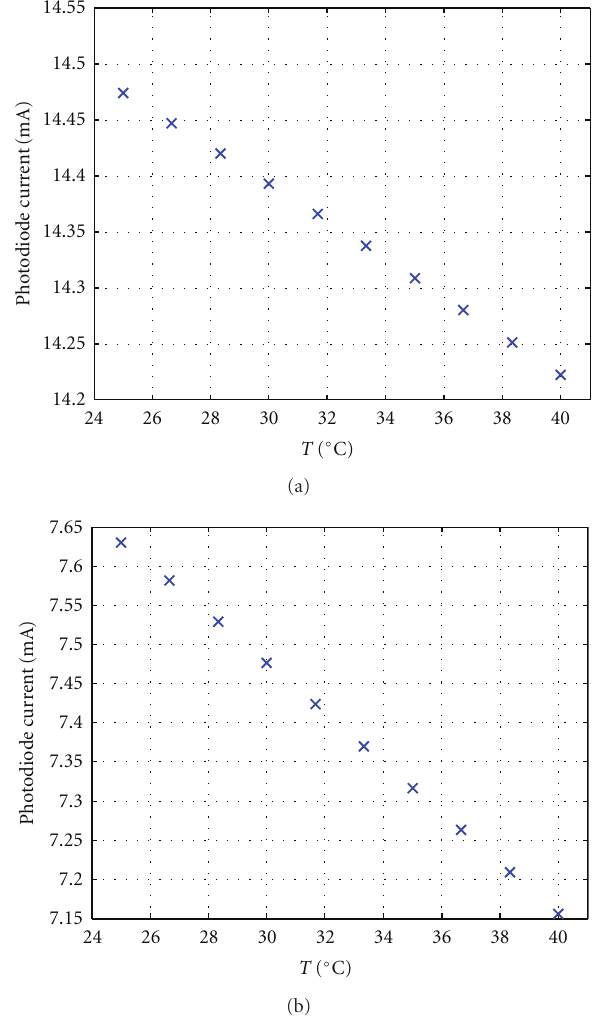
Figure 8: Photodiode current over temperature T for the dipole metamaterial (a) and for the EIT metamaterial (b).